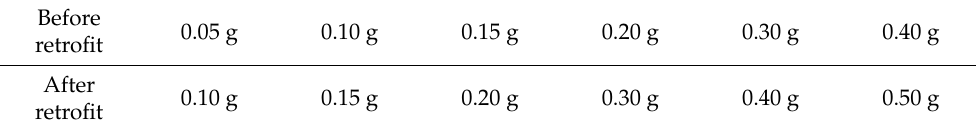
Table 2. Design basic acceleration of ground motion for structures before and after retrofitting. Before